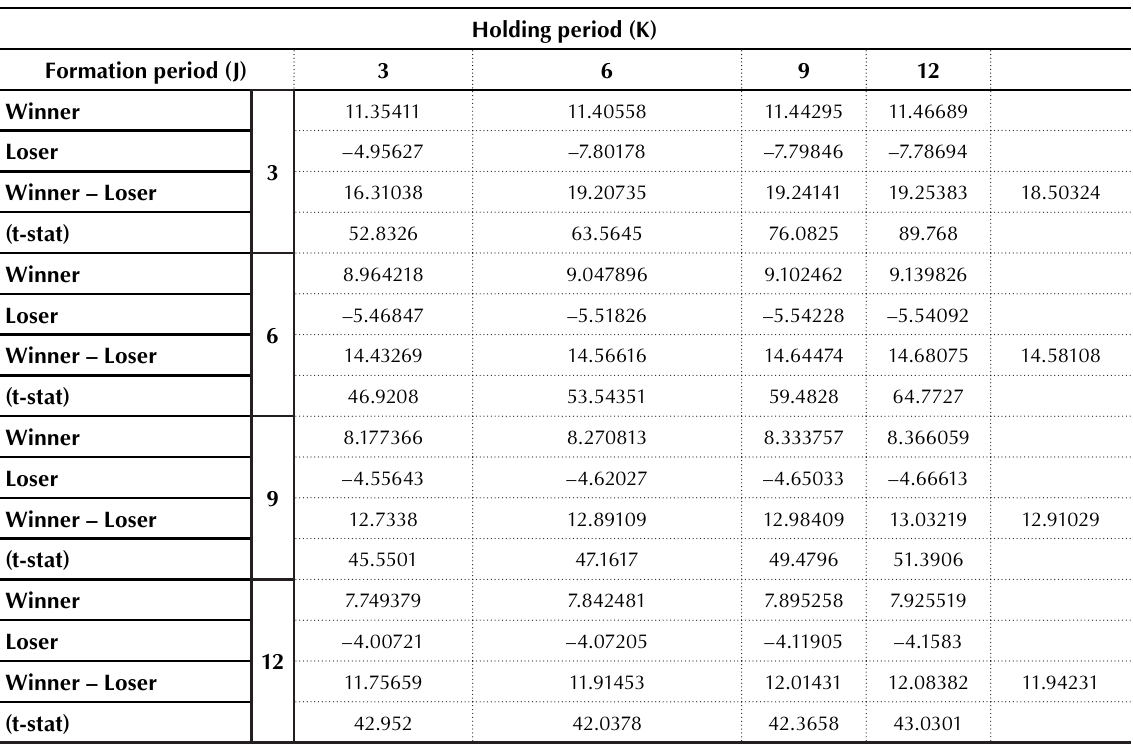
Table 1. Returns of monthly price momentum strategies